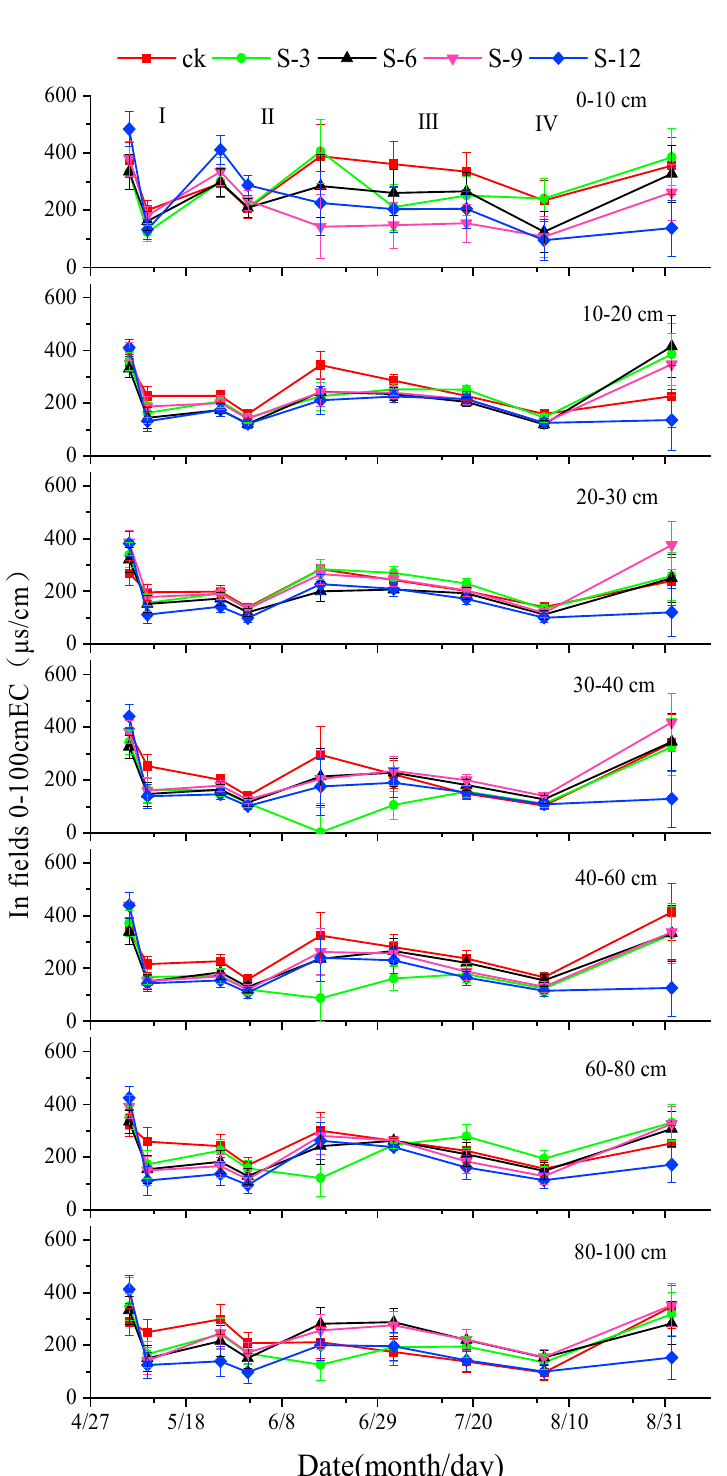
Figure 4. Variations of EC after adding super absorbent polymer from the whole maize growth period in fields soil column (0–100 cm). Data are presented in the average with standard error bars ( n = 3).